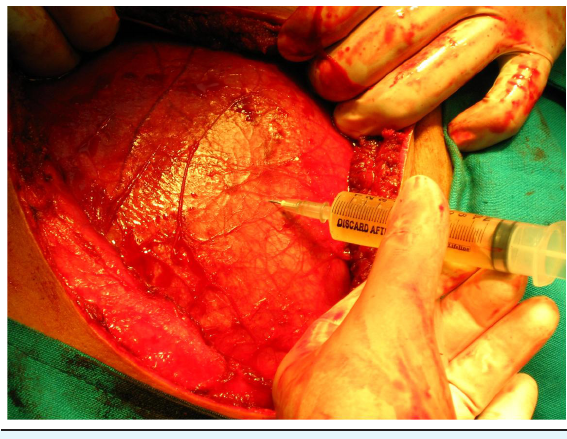
figure 3. showing hydronephrotic